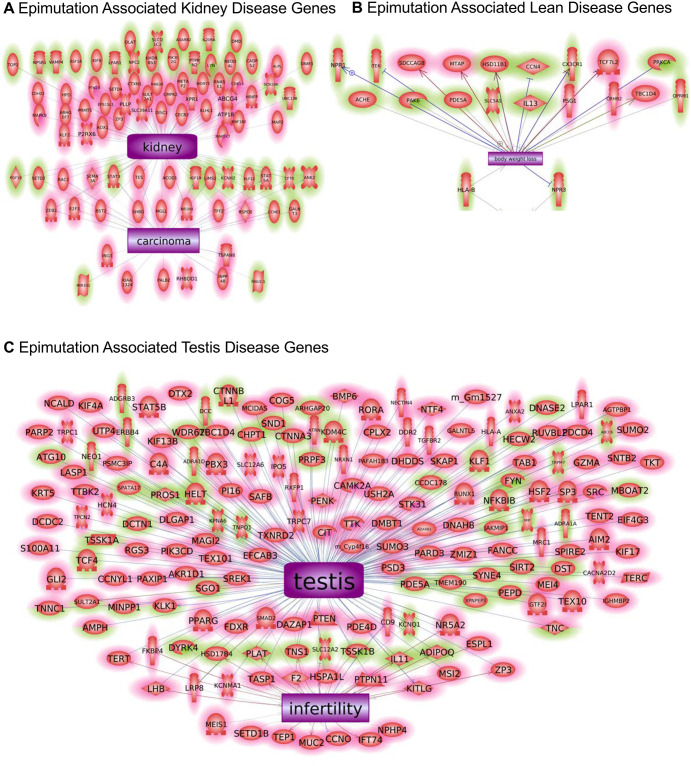
Epimutation associated previously identified disease genes.(A) Epimutation associated kidney disease genes. (B) Epimutation associated lean disease genes. (C) Epimutation associated testis disease genes. The green shading represents DMRs and pink shading DHRs. The gene shapes are identified as follows inset in Fig 7.